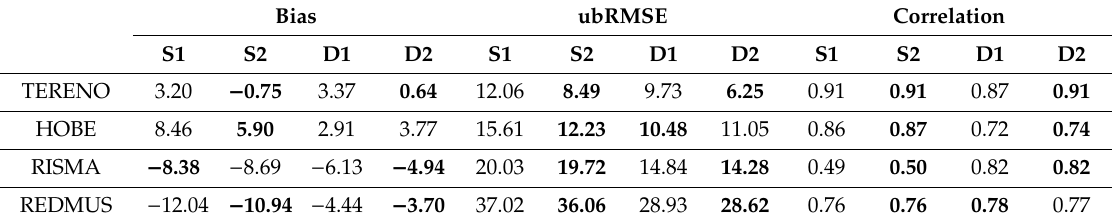
Table 2. Performance of SCA (S) and DCA (D) over the calibration sites.